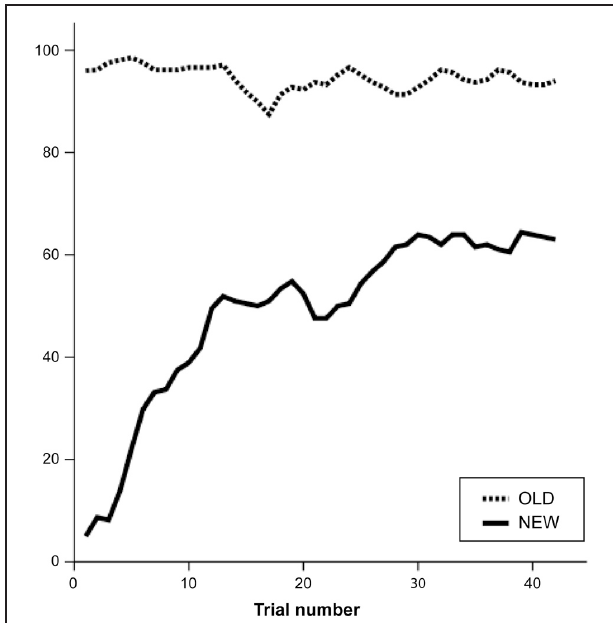
FIGURE 4 | Timecourse of task performance (accuracy, in %) over all pairs.